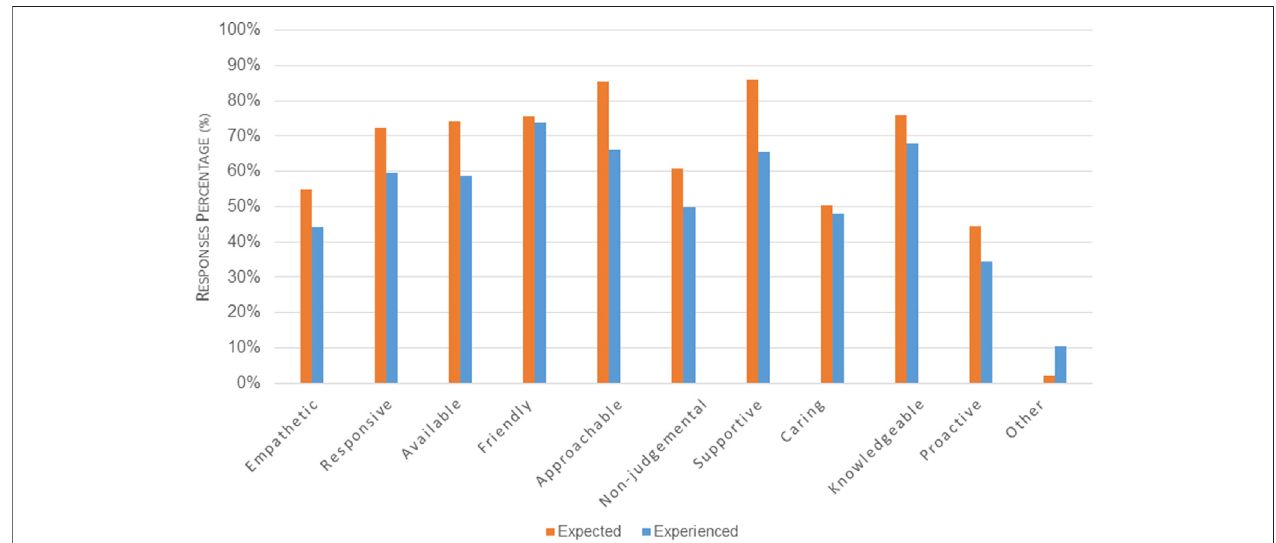
FIGURE 4 | Characteristics of a Personal Tutor (PT) that students expected compared with what they